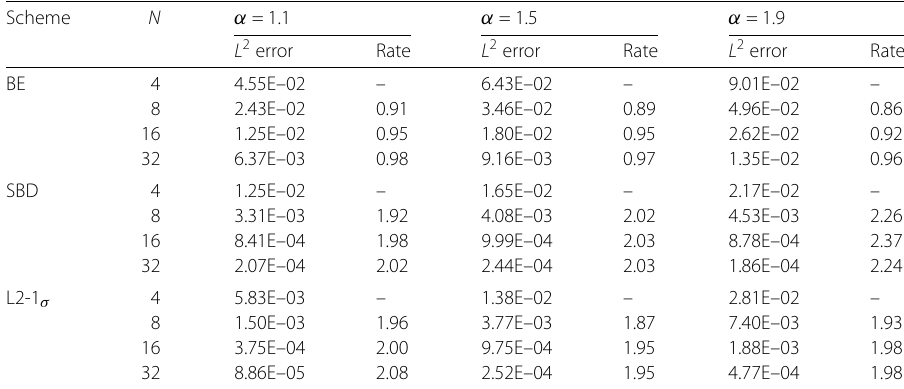
Table 1 The L 2 norm errors in time for Example 6.1 with h = 1/512